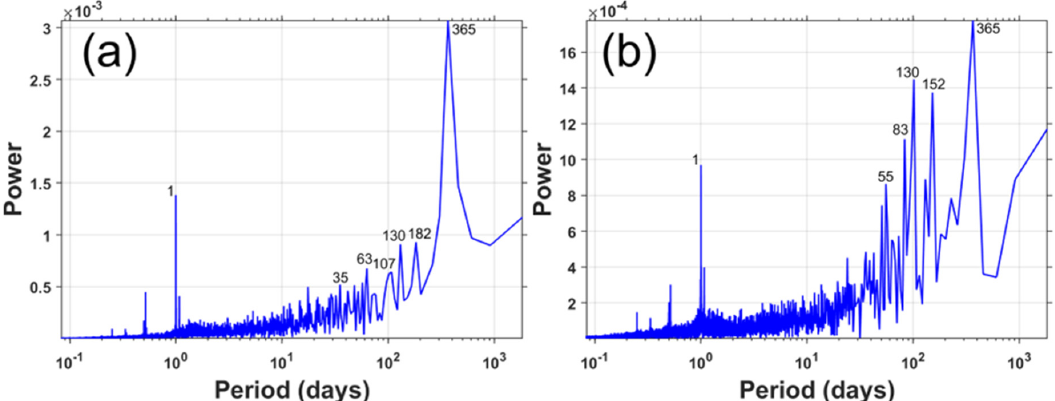
Figure 10. FFT power spectra of ( a ) Figure 9c and ( b ) Figure